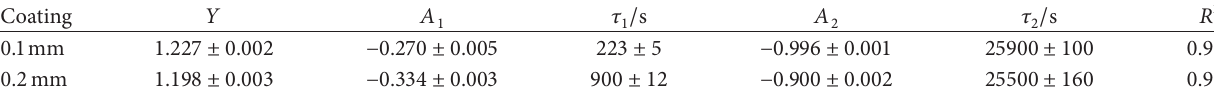
Table 2: Parameter values for the expression that was regressed to the simulated relaxation potential profile of coatings. The bulk conditions were 0.01 M NaCl, pH 9, and 10 −15 M Al 3+ , and the applied potential was − 1.9V.